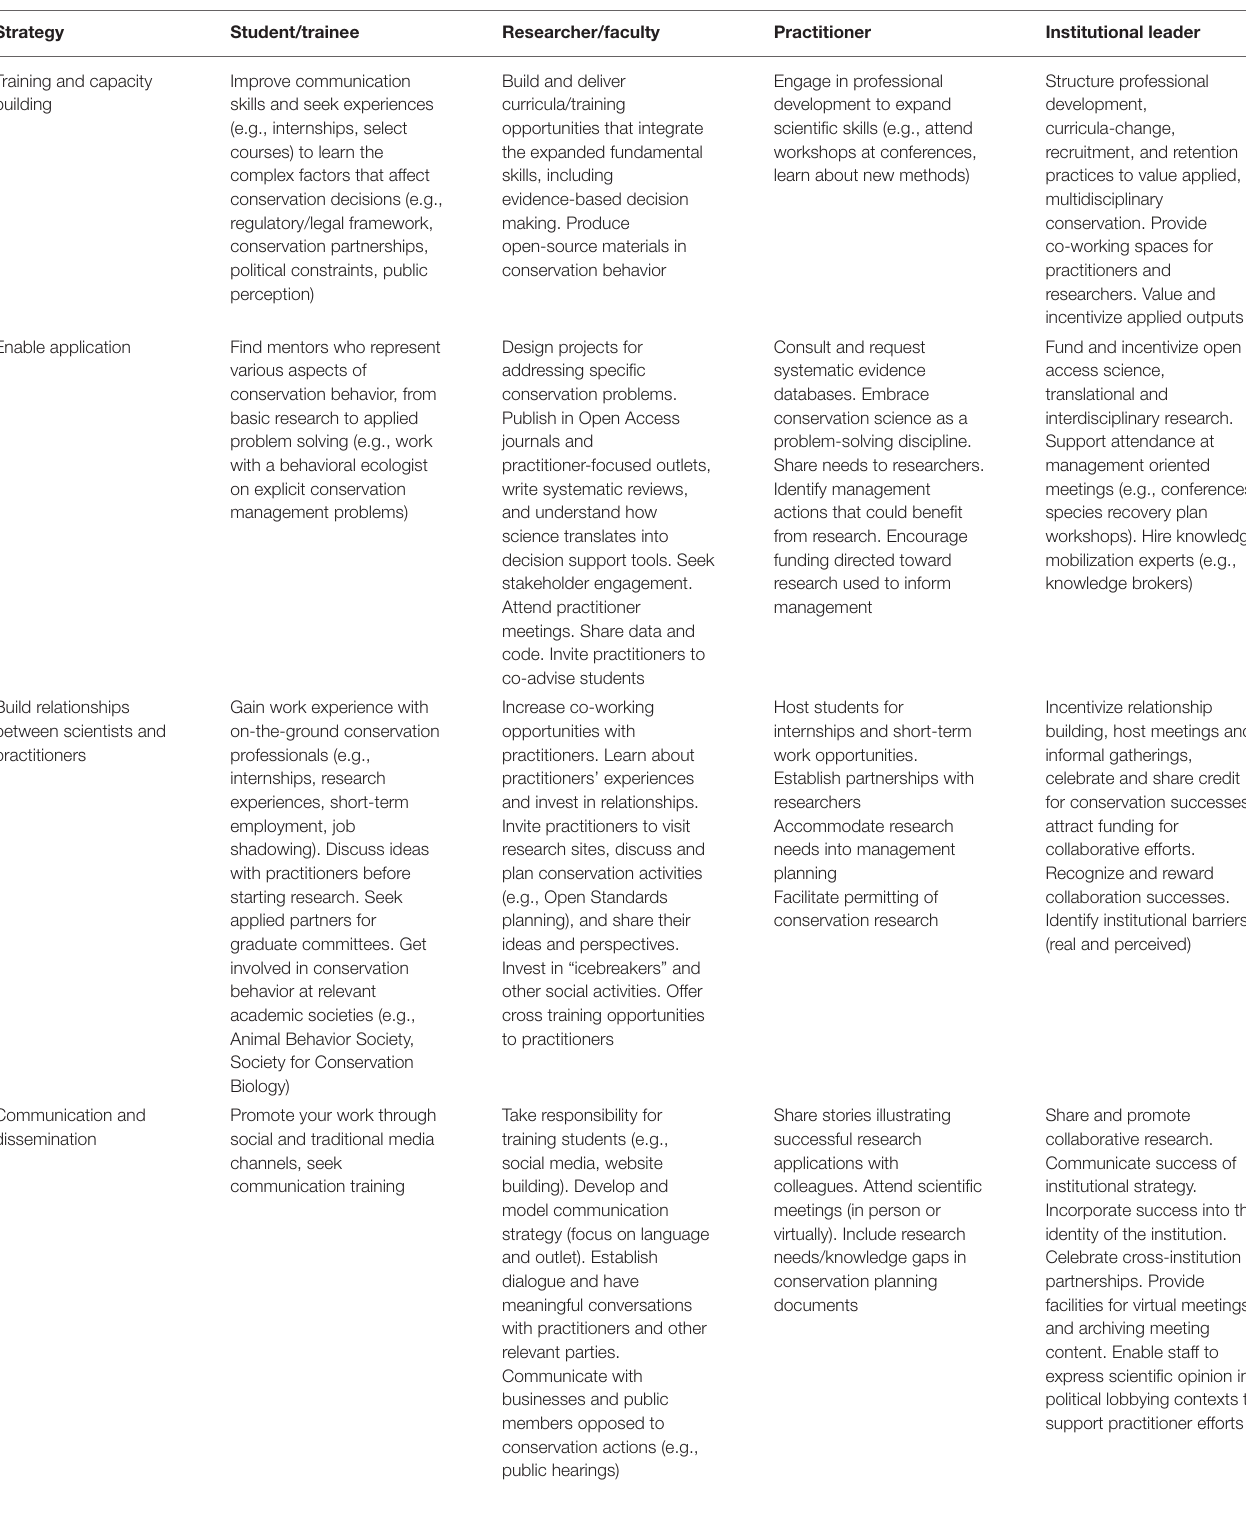
TABLE 2 | Actors and actions relevant to each strategy.